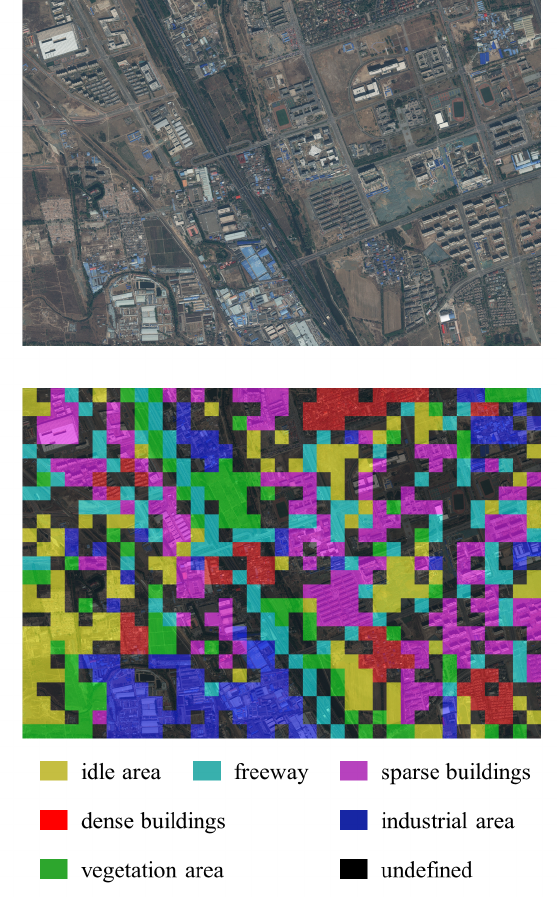
Figure 3. Changping data